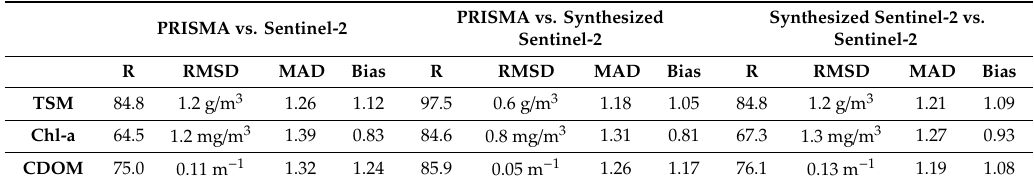
Figure 12. Agreement analyses among the CDOM derived from PRISMA and Sentinel-2 images in terms of R and RMSD. Table 4. The agreement analyses among the retrieved constituents in terms of average R and RMSD.